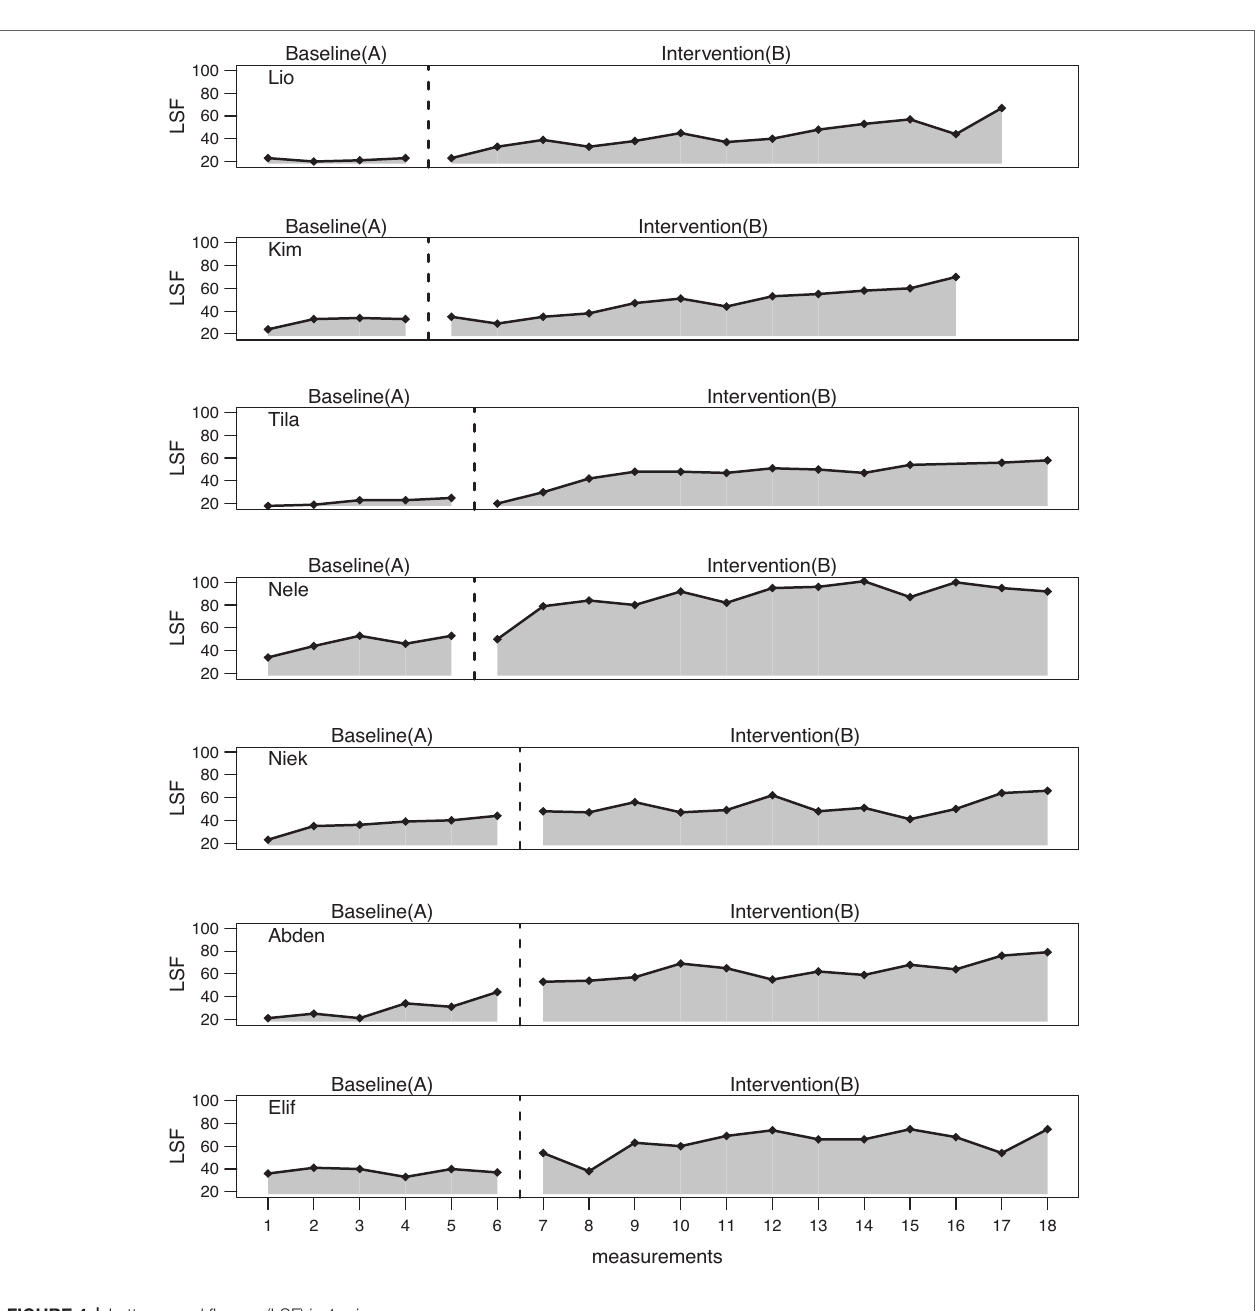
FIGURE 4 | Letter sound fluency (LSF) in 1